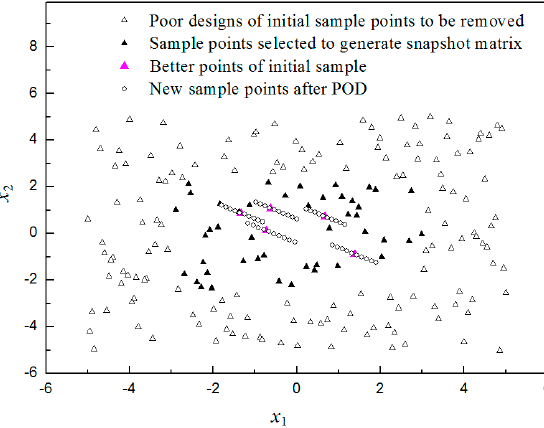
Figure 9. Corresponding distribution of the sample points.